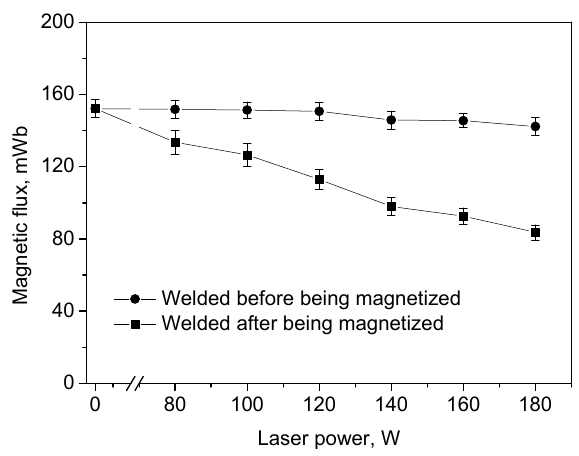
Figure 5. Effect of laser power on magnetic flux.